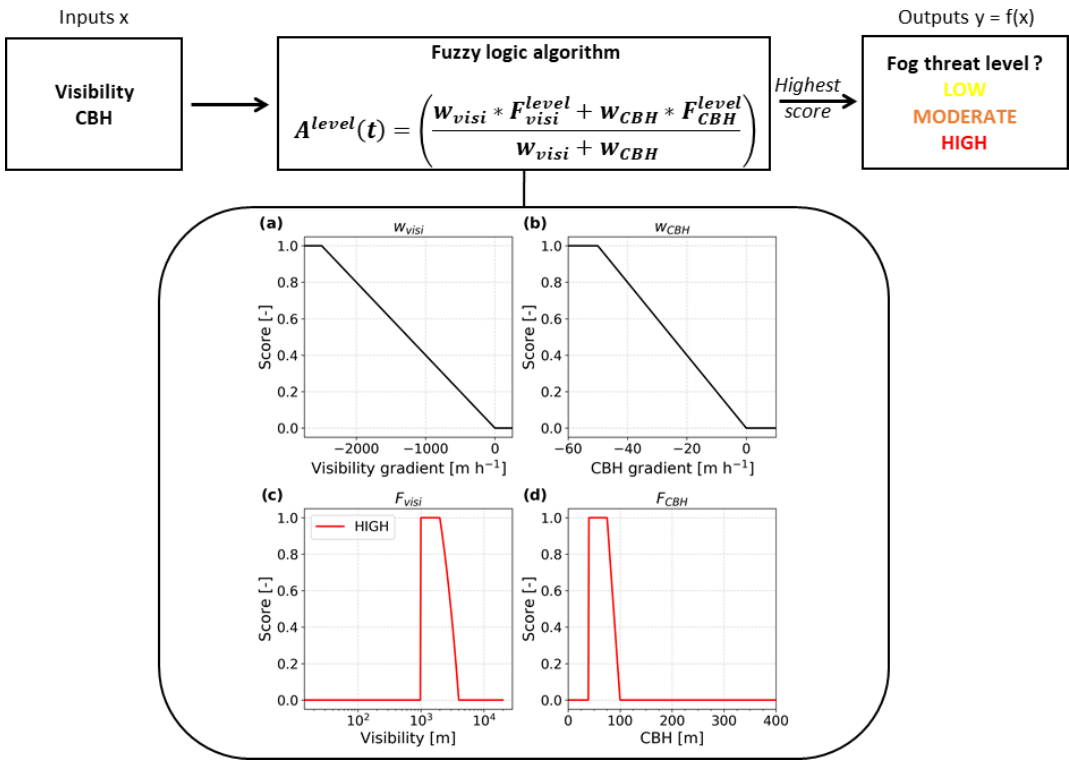
Figure 4. Fuzzy logic scheme used in the PARAFOG v2.0 algorithm for the STL module. Weights associated with (a) visibility and (b) CBH gradients. HIGH alert membership functions for (c) the visibility and (d) the CBH